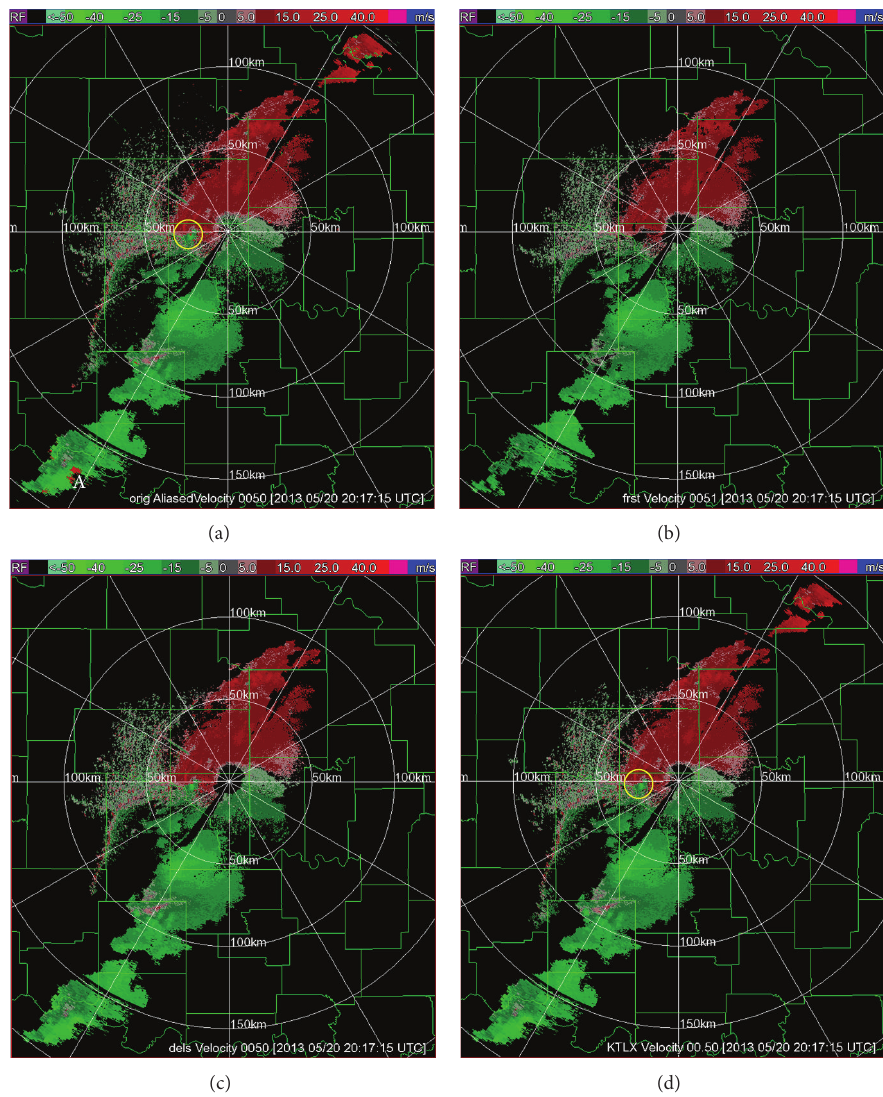
Figure 5: As in Figure 4 but for the Moore, Oklahoma, tornadic storm scanned by the KTLX radar using VCP12 with V 𝑁 = 26.1 ms −1 on 0.5 ∘